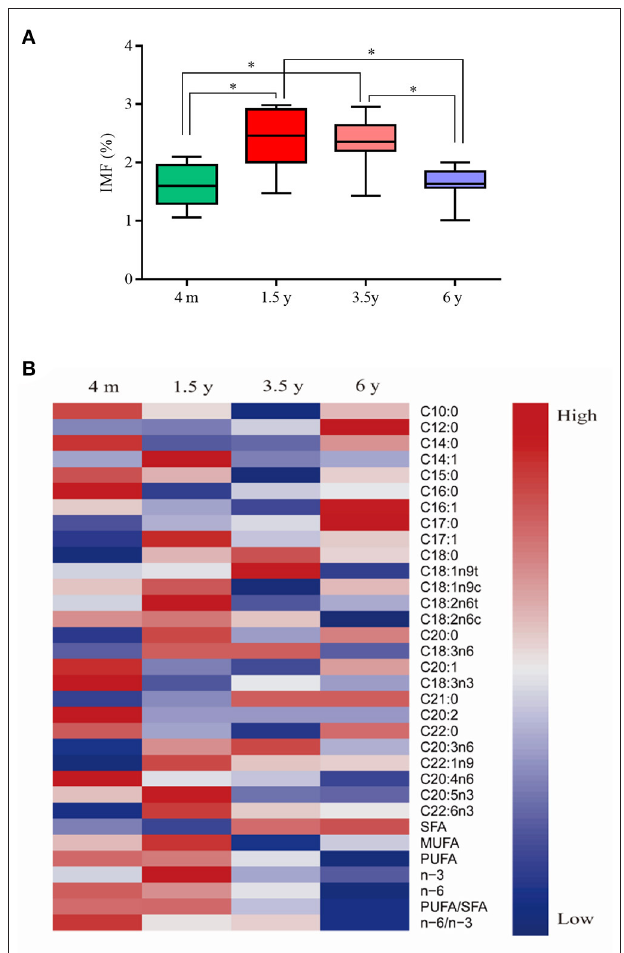
FIGURE 1 | Intramuscular fat (IMF) and fatty acid content in Tibetan sheep meat at different ages. (A) Box plot of IMF content in Tibetan sheep meat at different ages. (B) Heat map of fatty acid composition in Tibetan sheep meat at different ages. *Difference is significant at P <